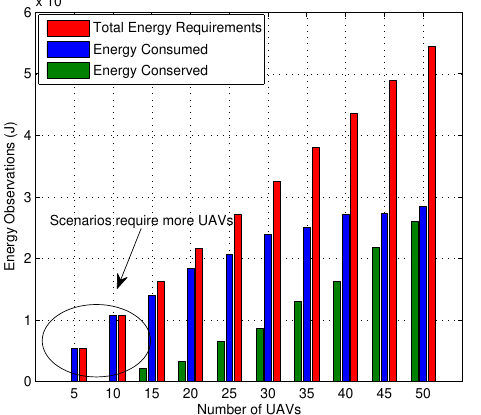
Figure 10. Energy conservation vs. number of